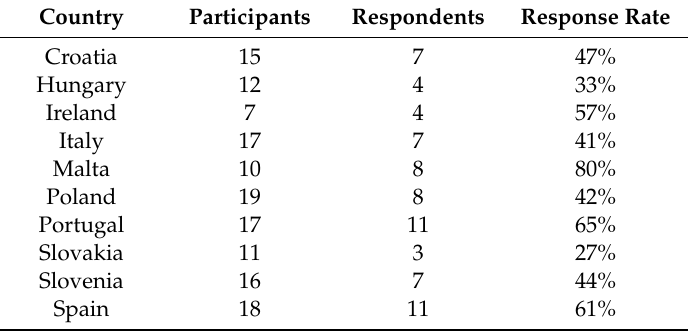
Table 1. Summary of the feedback questionnaire respondents from ten of fourteen national policy dialogs of CHRODIS PLUS.